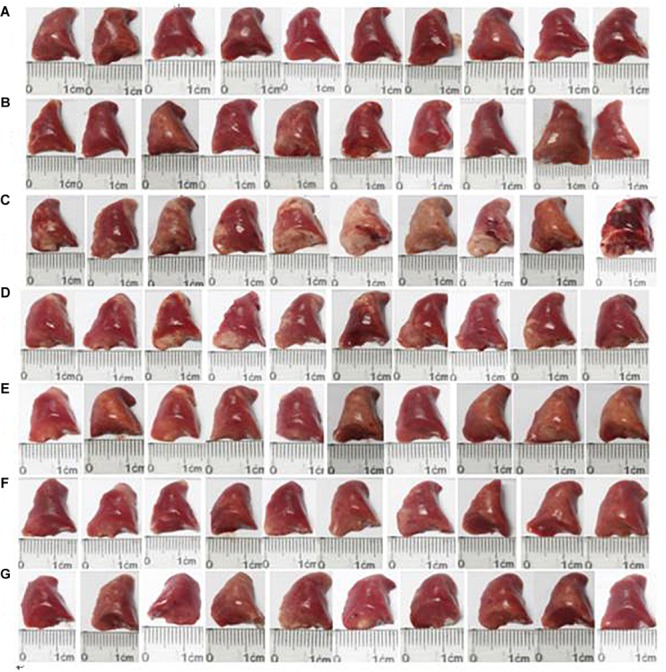
Effect of HSYA on lung morphology in guinea pigs. (A) Normal control; (B) HSYA blank; (C) OVA; (D) OVA+50 mg/kg HSYA; (E) OVA+75 mg/kg HSYA; (F) OVA+112.5 mg/kg HSYA; (G) OVA+3 mg/kg DXM.